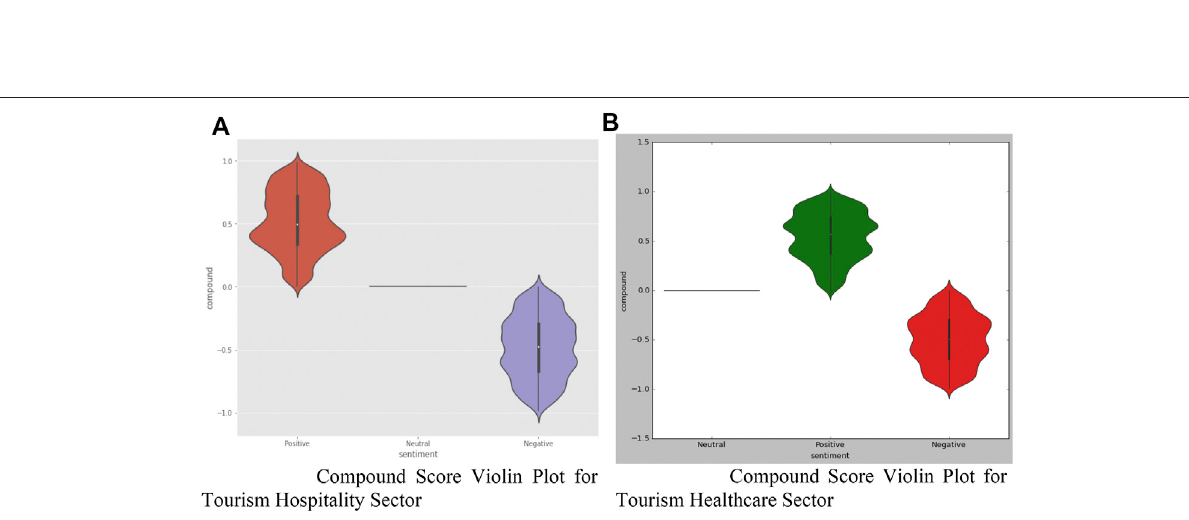
Frontiers in Computer Science |